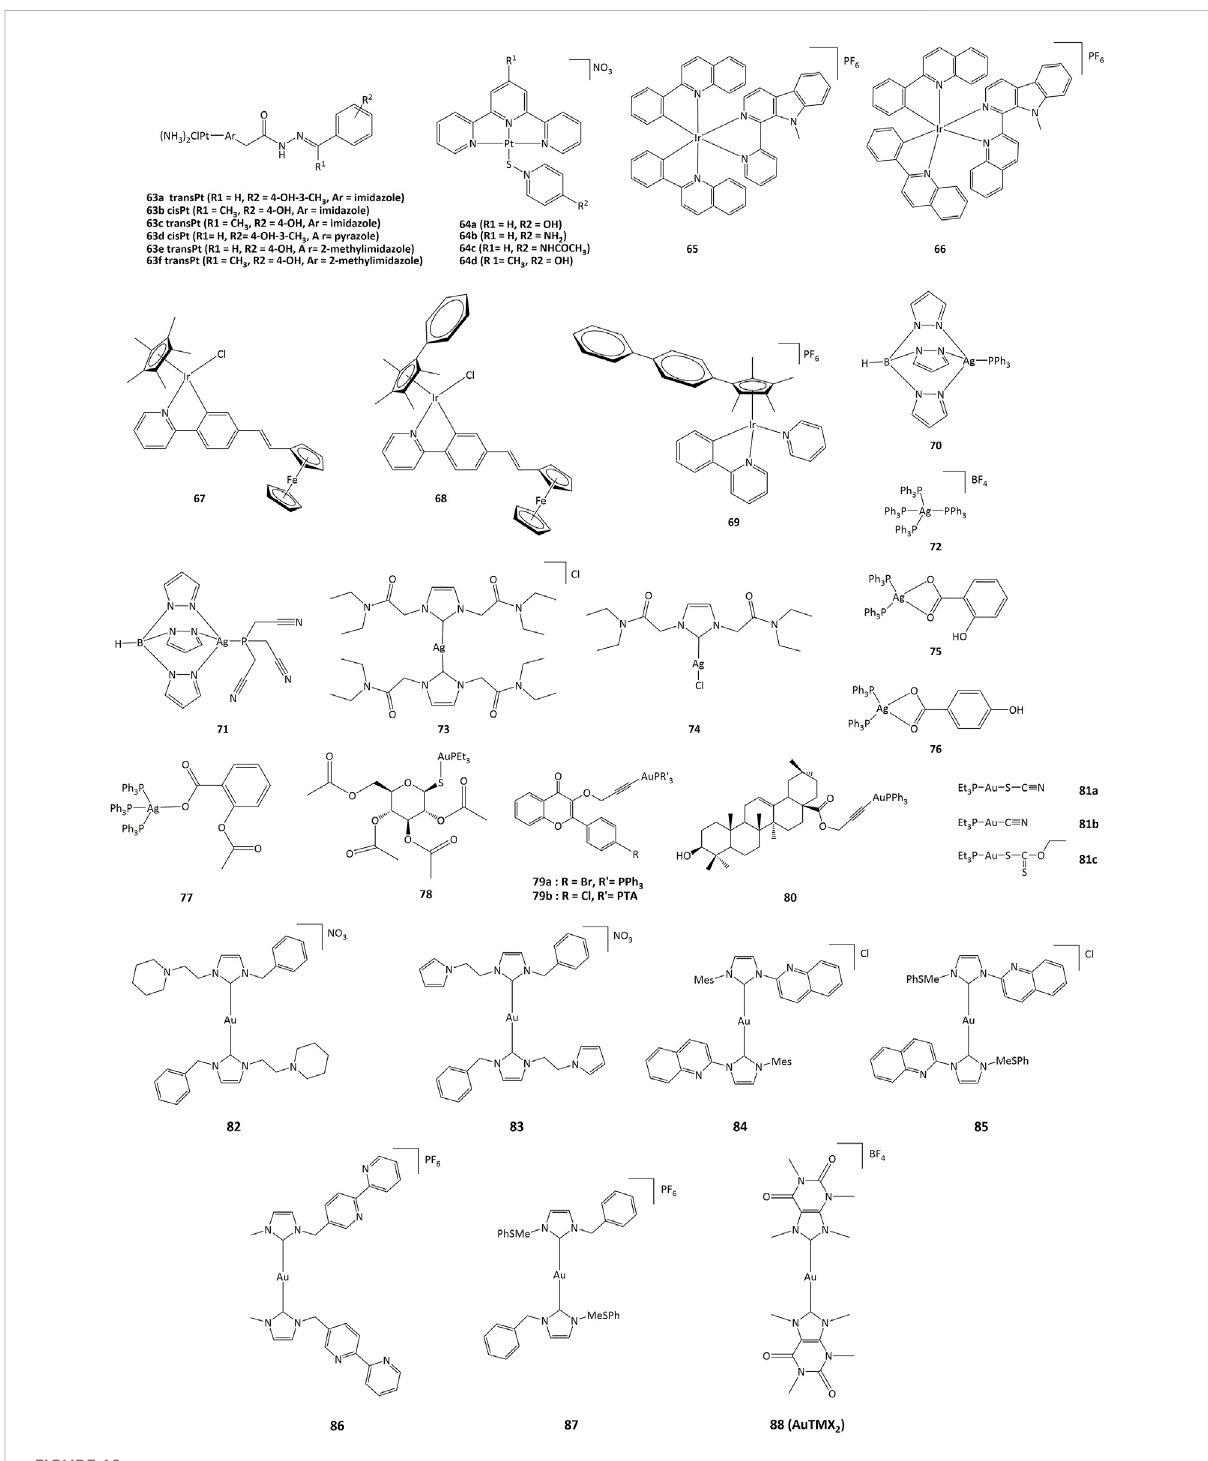
FIGURE 10 Platinum, iridium, silver and gold compounds studied as potential enzymes